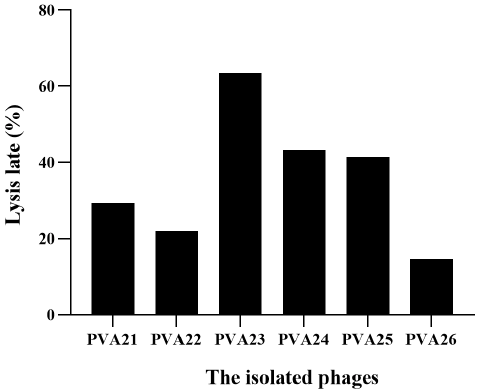
Figure 2. Lysis rate of the six isolated phages using the 41 V. alginolyticus strains. Table 2. Host range of the isolated phages to the V. alginolyticus strains.